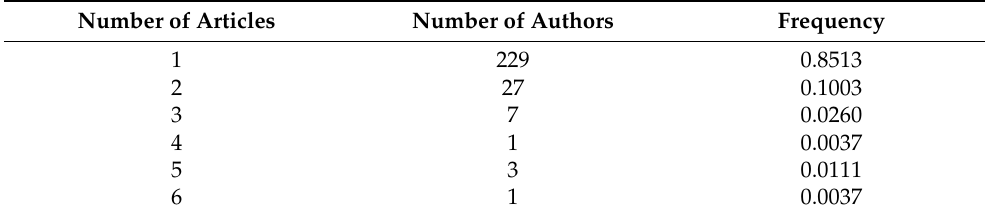
Figure 3. Lotka’s law curve. Source: RStudio results. Table 2. The number of articles and frequency are based on Lotka’s law using RStudio. Table 2. The number of articles and frequency are based on Lotka’s law using Number of Articles